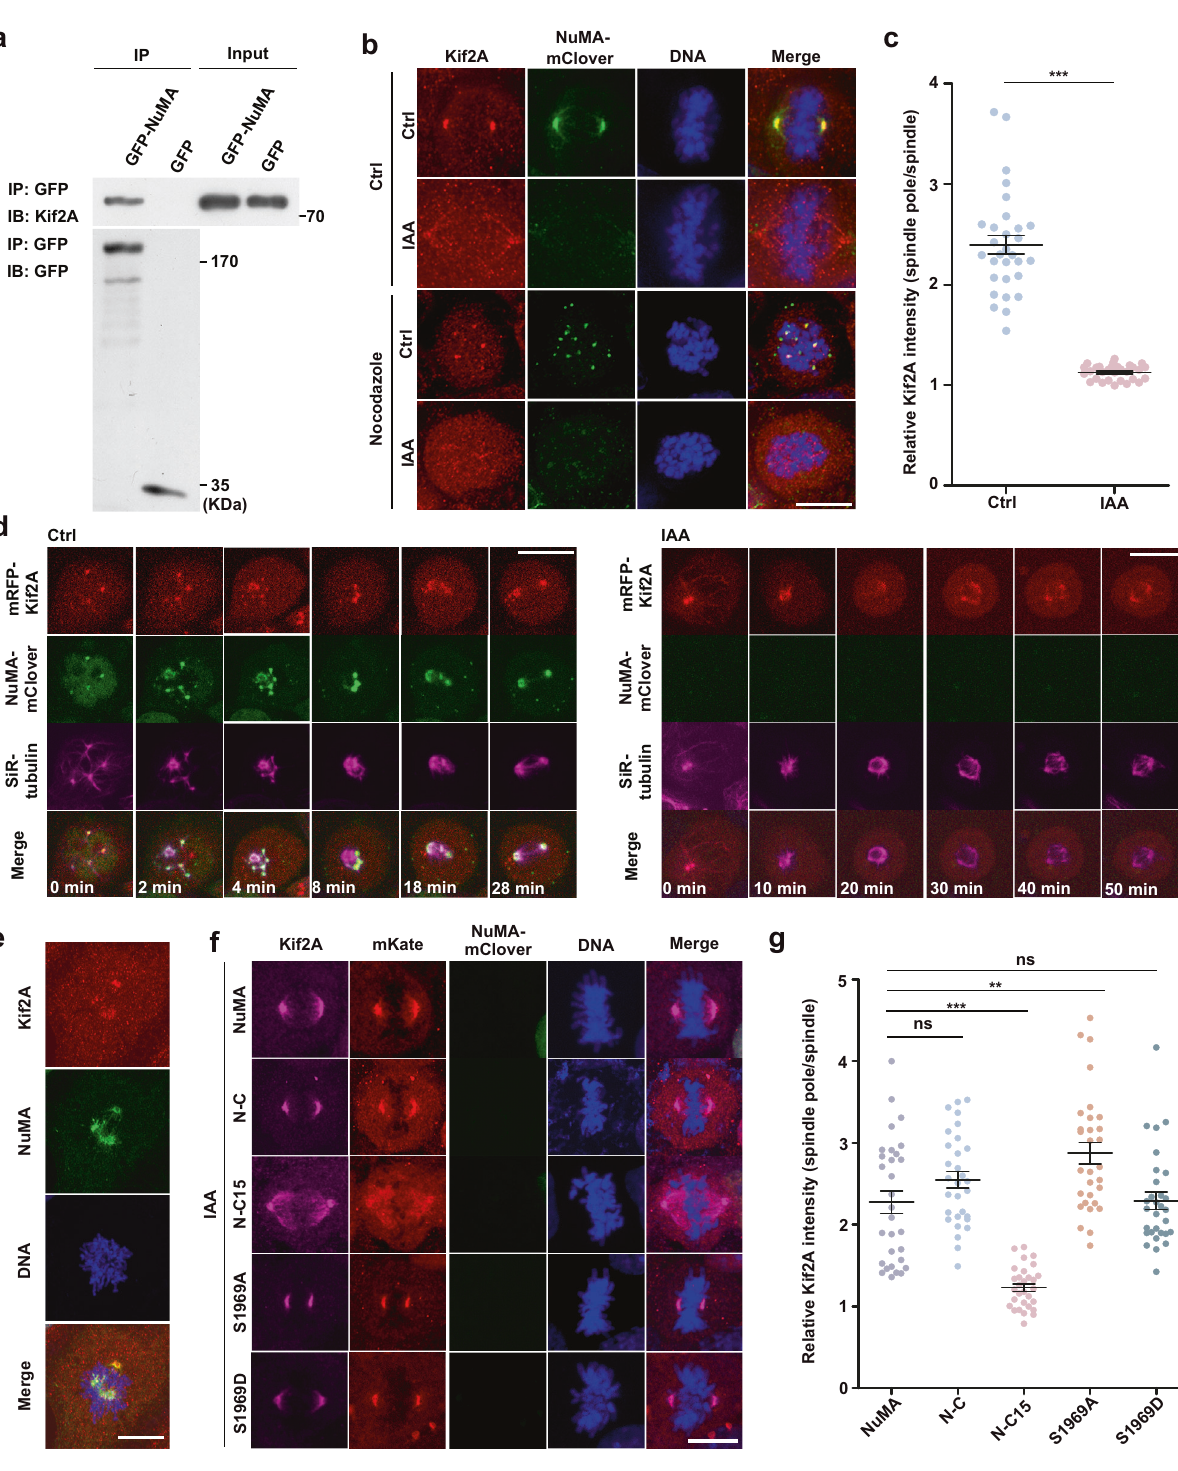
occurs. Obviously, the spindle pole is one of the key regulation centers that not only focuses minus-end microtubules but also dynamically enriches key regulators and hosts multiple bio- chemical reactions to depolymerize the spindle microtubules to keep the poleward microtubule fl ux for dynamic balance of the spindle 8,10,44,45 . However, the underlying mechanisms for pole- ward movement of the spatiotemporal components and organi- zation of the poles are still poorly understood. Here we identify